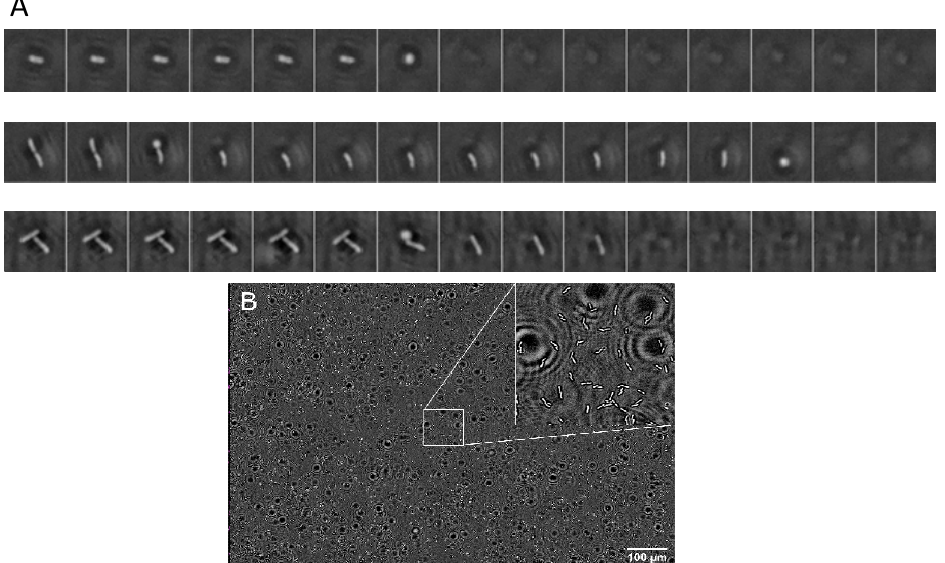
Figure 5. ( A ) Time-lapse sequences in three regions of interest, illustrating the different phases of lysis resulting from phage replication. ( B ) The entire FoV of our system (1.1 mm × 0.8 mm) with bacteria observed on the inner surface of the coverslip (bright rods) covering the gene frame chamber. Inset shows a magnified region of interest of 100 µm × 100 µm.